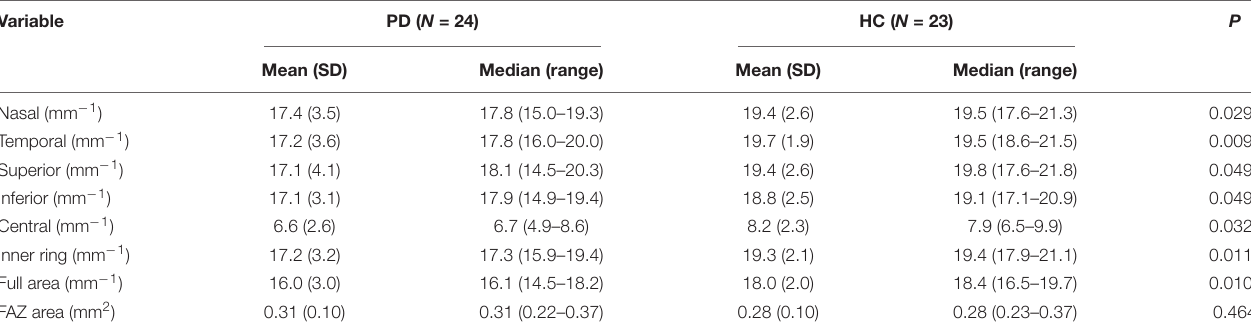
TABLE 3 | Comparison of macular microvascular density and FAZ area between the PD patients and healthy controls in the 3-mm-diameter region.